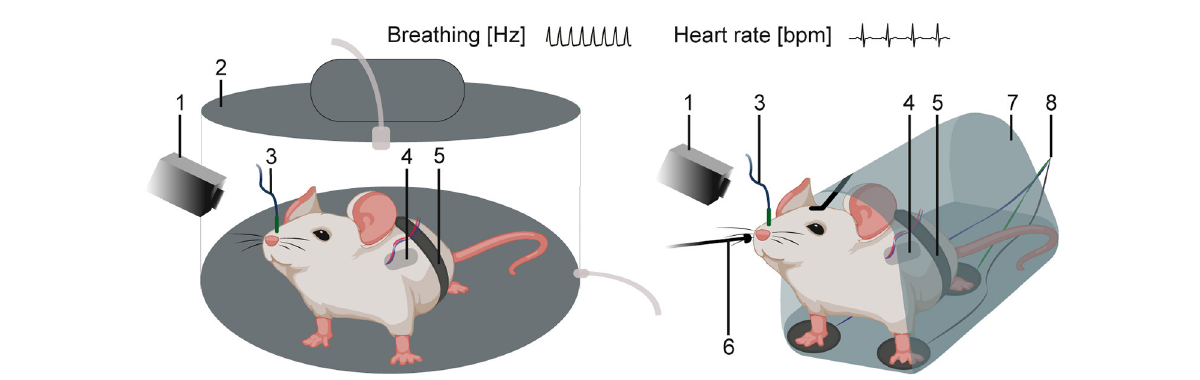
FIGURE5 Schematics of in vivo techniques for the recording of cardiac and respiratory activity. Mouse in a whole-chamber plethysmograph (left) or in a restraining system (right) with additional recording methods. (1) video monitoring and infrared camera, (2) whole-chamber plethysmography, (3) intranasal cannula, (4) telemetry system, (5) movement sensor, (6) external temperature probe (thermocouple), (7) restraining system, and (8) 3-point